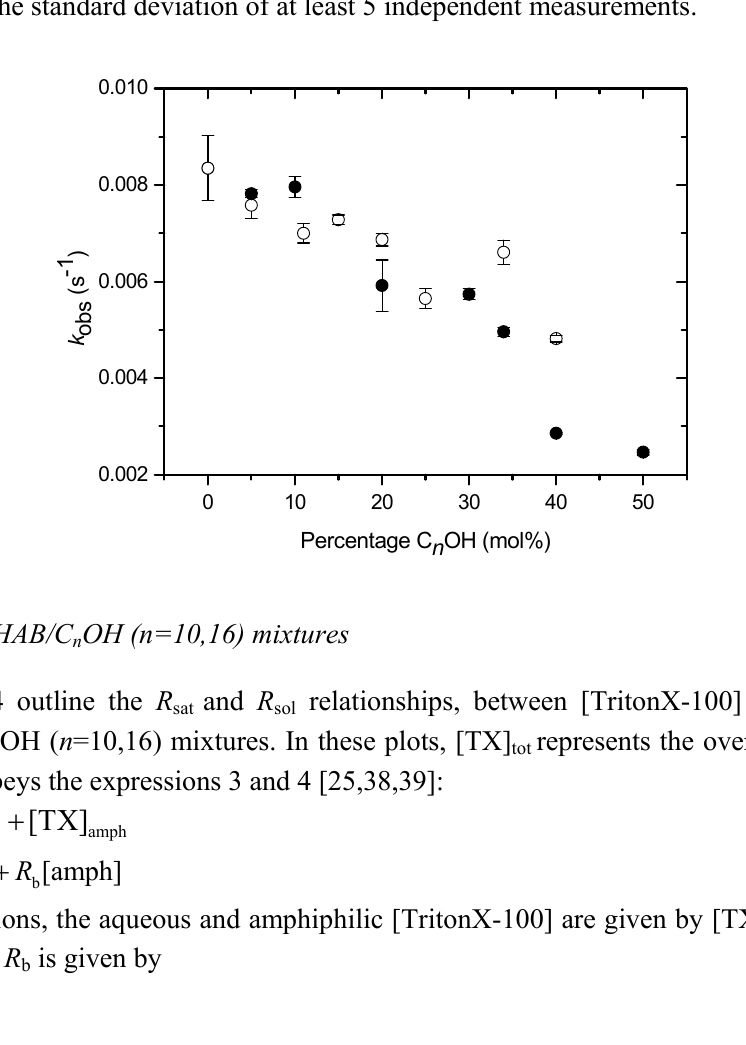
OH ( • ) and C OH ( ○ ). Error bars denote 10 16